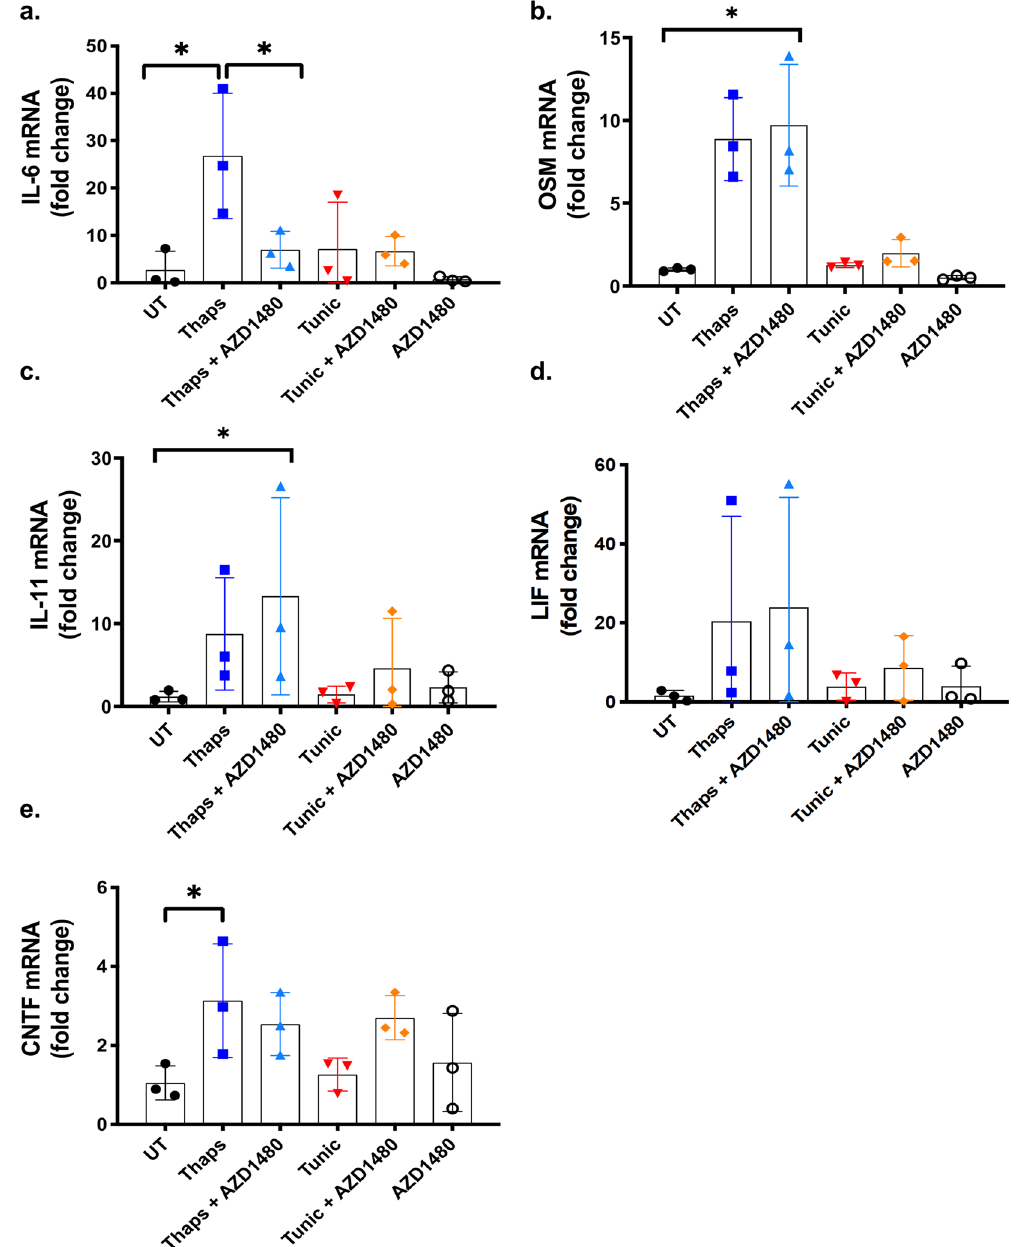
Figure 8. JAK-dependent regulation of the IL-6 cytokine family in macrophages. ( a – e ) Primary BMD murine macrophages were pre-treated for 30 min with the JAK1/2 inhibitor, AZD1480 (2 µ M) followed by stimulation with 1 μ M thaps and 5 μ M tunic for 4 hours. mRNA expression was analyzed by qPCR. * p ≤ 0.05, N =